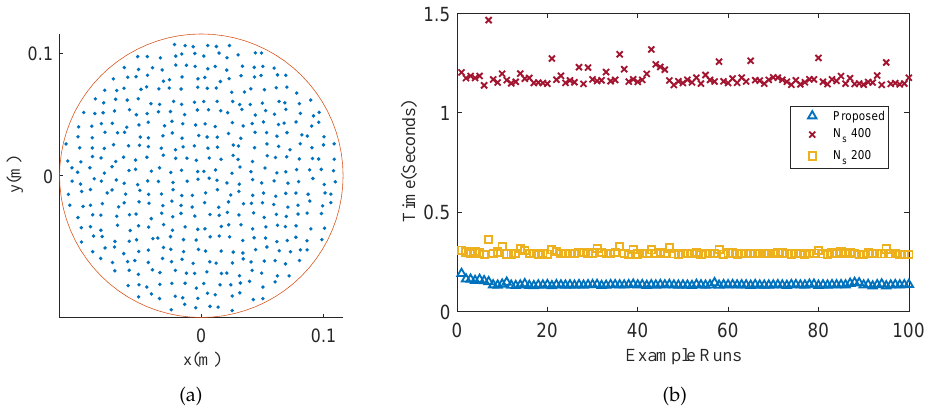
Figure 4. ( a ) A sample distribution of array elements for Section 3.2. ( b ) Computing time comparison of example Section